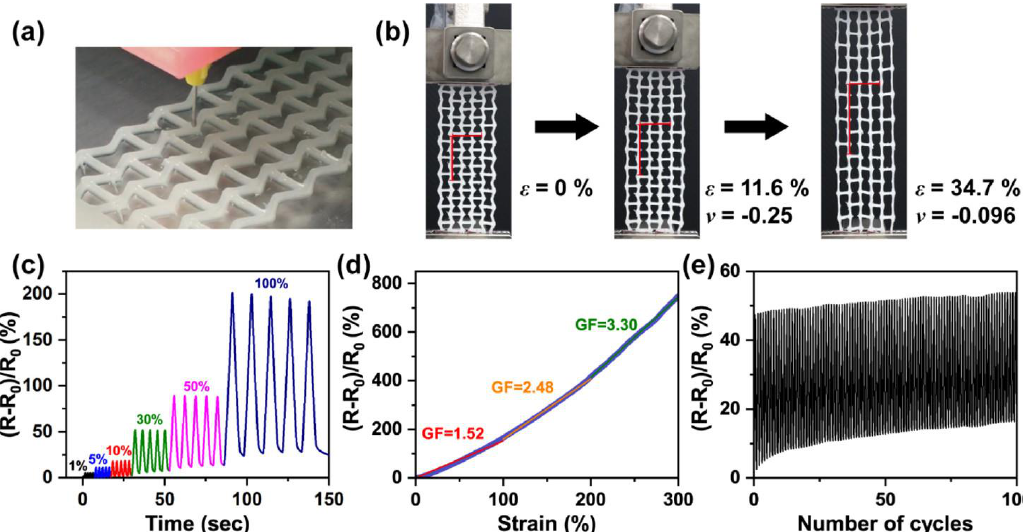
Figure 3. “ Performance of 3D printed strain sensors with resistance change. ( a ) Photograph of the printing process. ( b ) Dimensional change in the auxetic sensor during stretching. ( c ) Relative resistance change in the sensor at different strains. ( d ) Variation in relative resistance vs. strain. The slope of linear fitting corresponds to the gauge factors in the range of strain from 0 to 100%, 100 to 200%, and 200 to 300%, respectively. ( e ) Relative resistance change in the sensor at 30% strain for 100 cycles.” [Chun-Wei LaiChun-Wei Lai, “3D Printable Strain Sensors from Deep Eutectic Solvents and Cellulose Nanocrystals|ACS Applied Materials and Interfaces.” https://pubs.acs.org/doi/10.1021/acsami.0c11152 (accessed 22 October 2020). Reproduced with